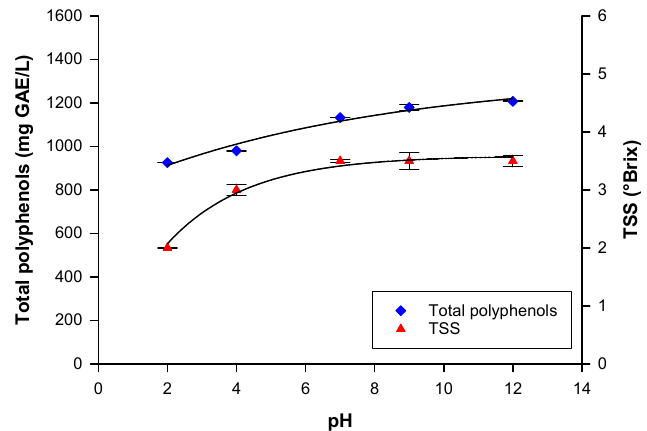
Figure 4. E ff ect of pH on total polyphenol and total soluble solid (TSS) Figure 4. Effect of pH on total polyphenol and total soluble solid (TSS) yields.